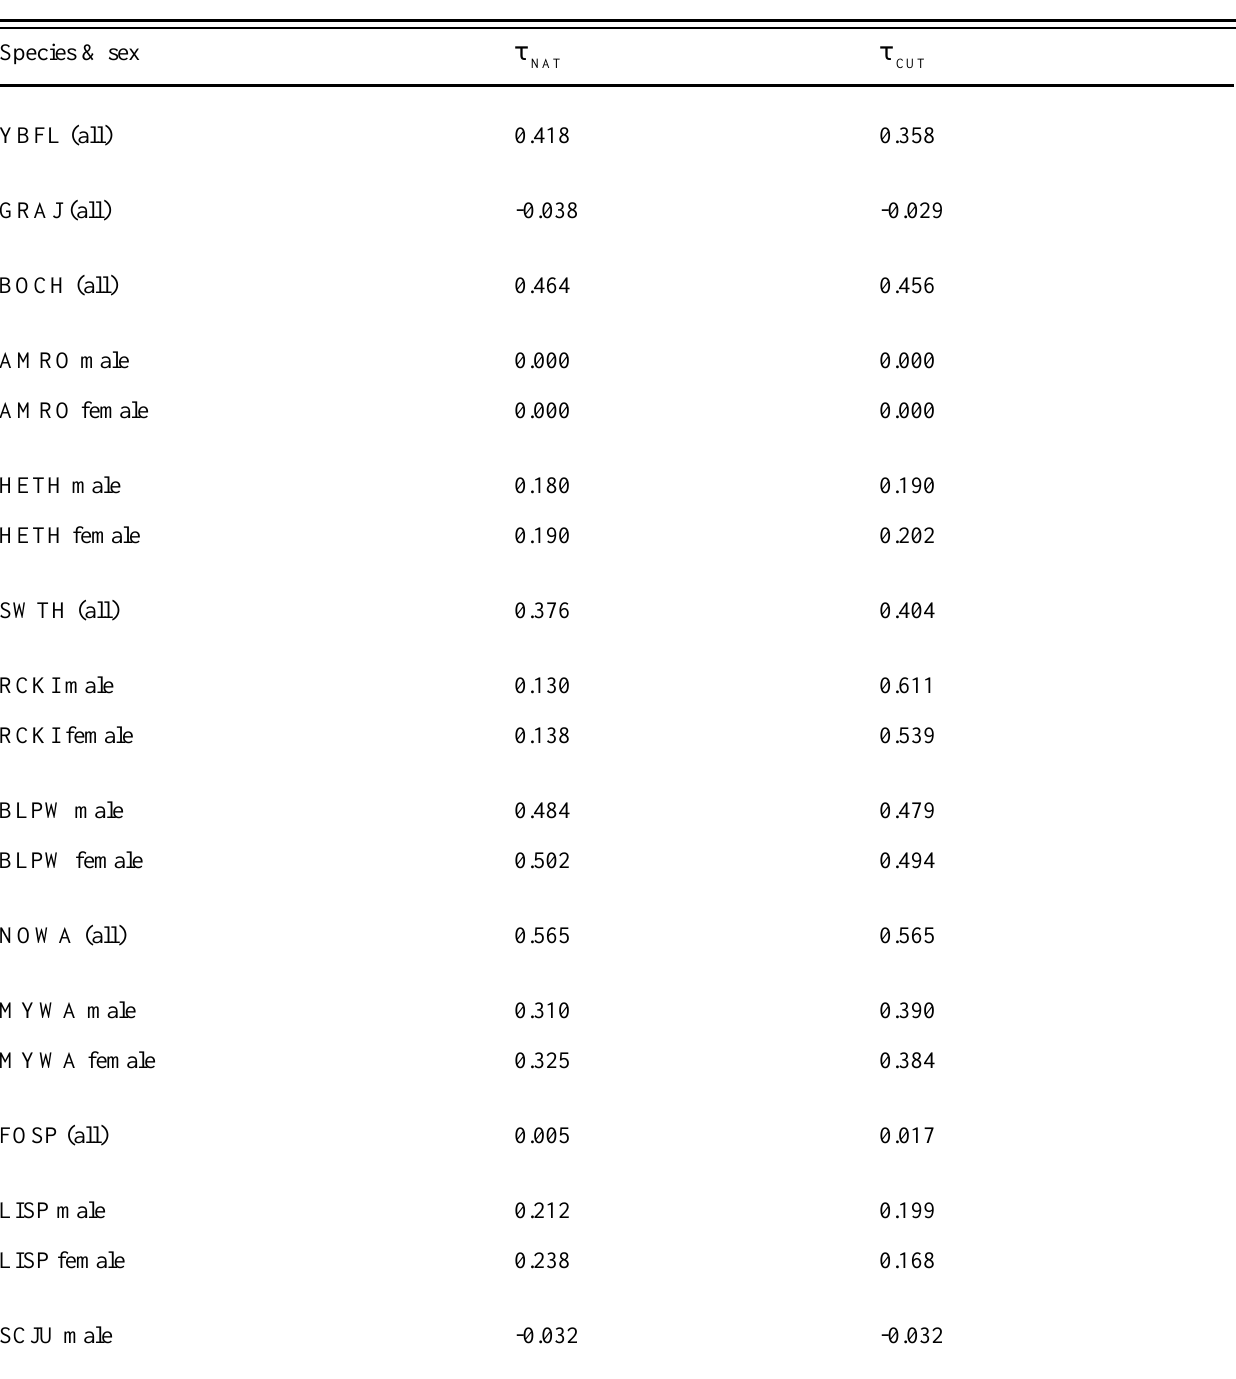
Table 4. Estimated proportions of transients ( t ) in captures of unmarked birds by landscape type and, when possible, sex for each species during the breeding period in western Newfoundland, 2003–2006. Proportions were estimated from model averaged survival rates (reported in Table 3) using the formula (1-( S S )). Species codes are from Table breeding season